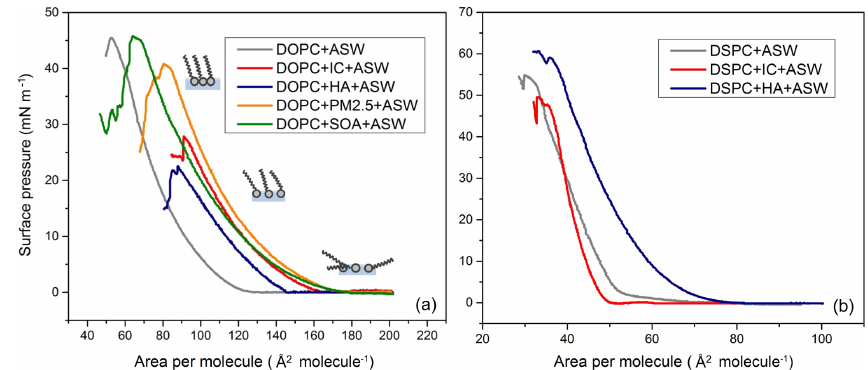
Figure 2. Surface pressure–area ( π – A ) isotherms of (a) DOPC and (b) DSPC monolayers on artificial seawater (ASW) containing IC, HA, PM 2 . 5 , and SOA samples. The insets show the phase behaviours of the DOPC monolayer at different pressures.